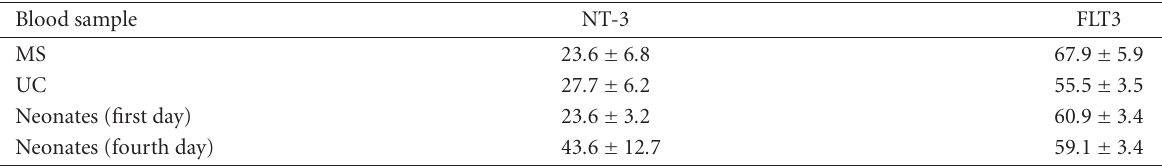
Table 2. Circulating neurotrophin-3 (NT-3) and FLT3 tyrosine kinase receptor (FLT3) (mean ± SD) levels (pg/mL) in mothers (MS), umbilical cords (UC) and neonates on the first (N1) and fourth (N4) days of full-term neonates ( n =